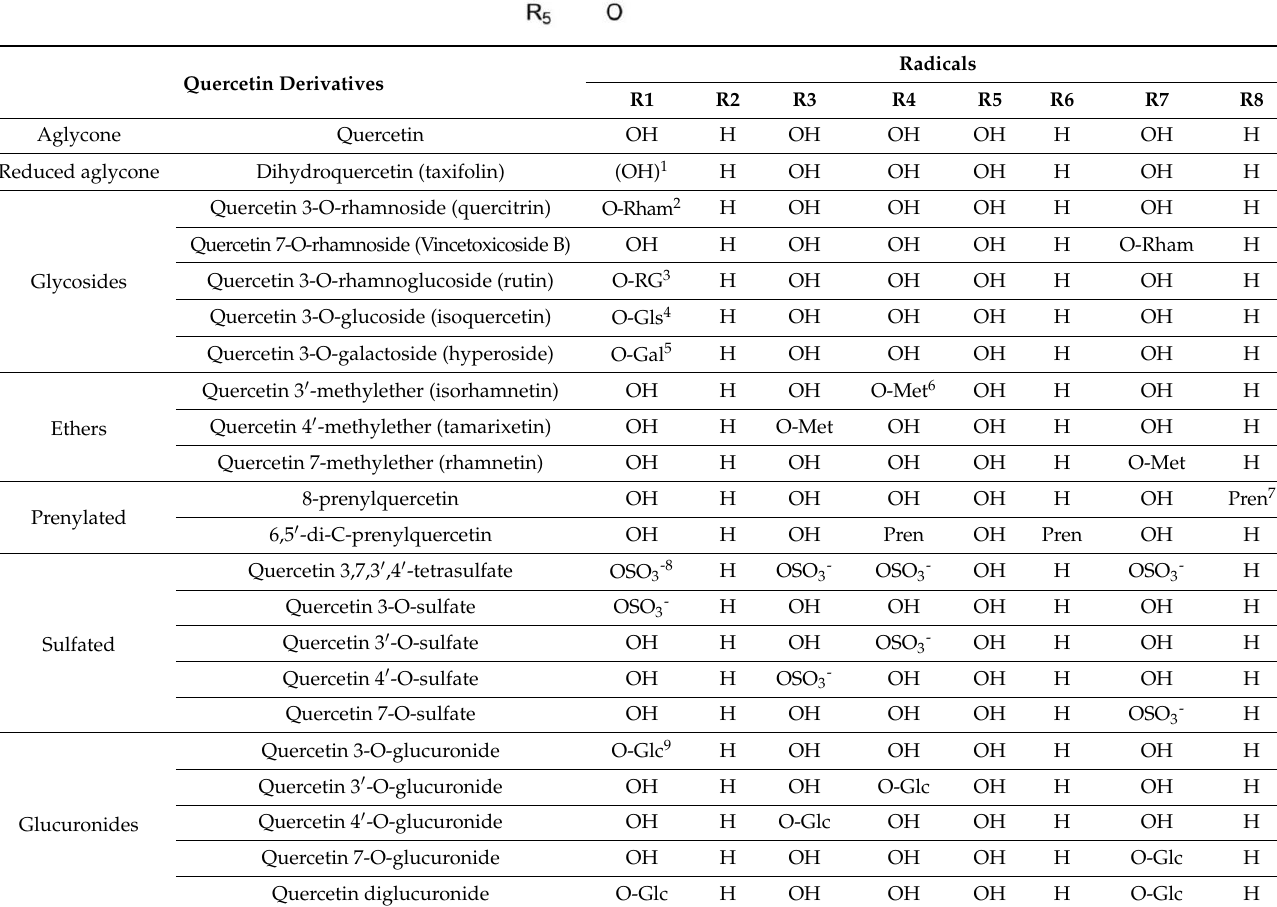
Table 1. Main derivatives and metabolites of quercetin.